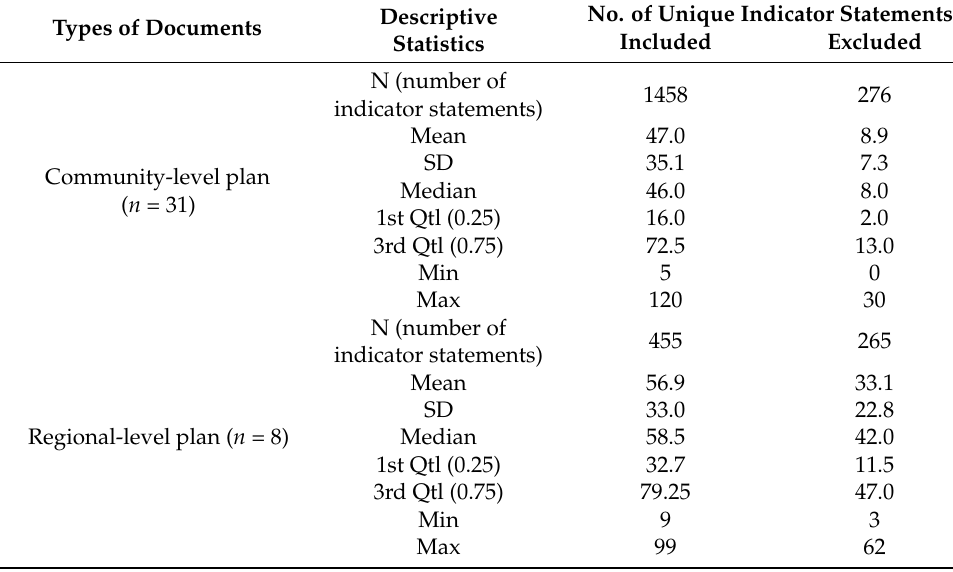
Table 2. Descriptive characteristics of unique indicator statements related to socio-political and built environments according to type of planning